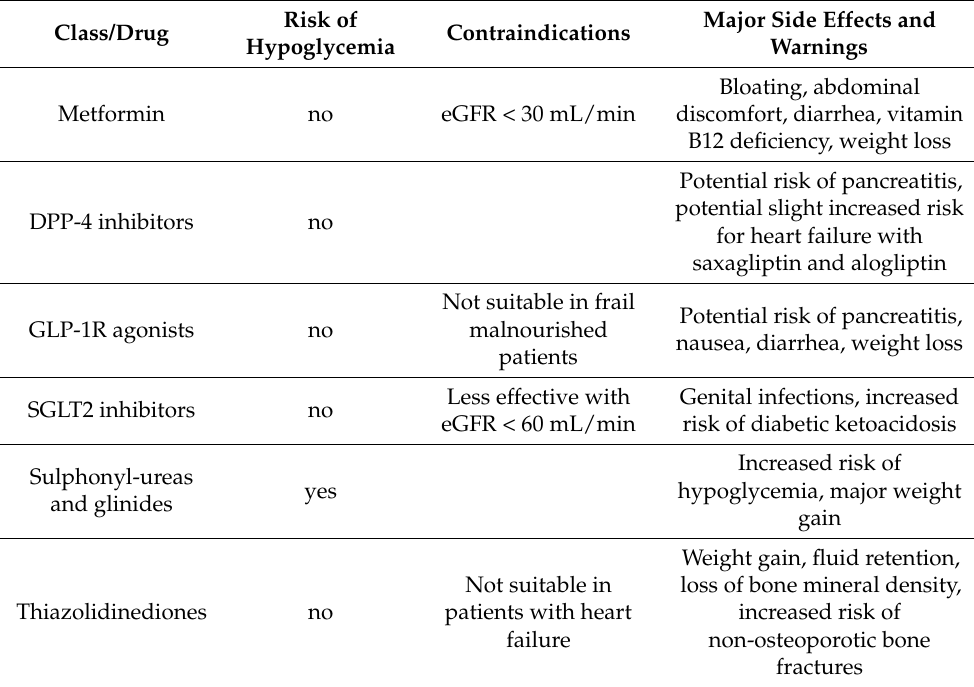
Table 2. Oral antidiabetic agents: contraindications and side